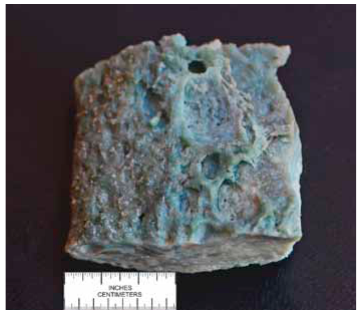
Fig. 3. Deposit formation pattern from the pilot biomass-firing stoker found during the annual maintenance procedure (Photo by A. Baleckis)